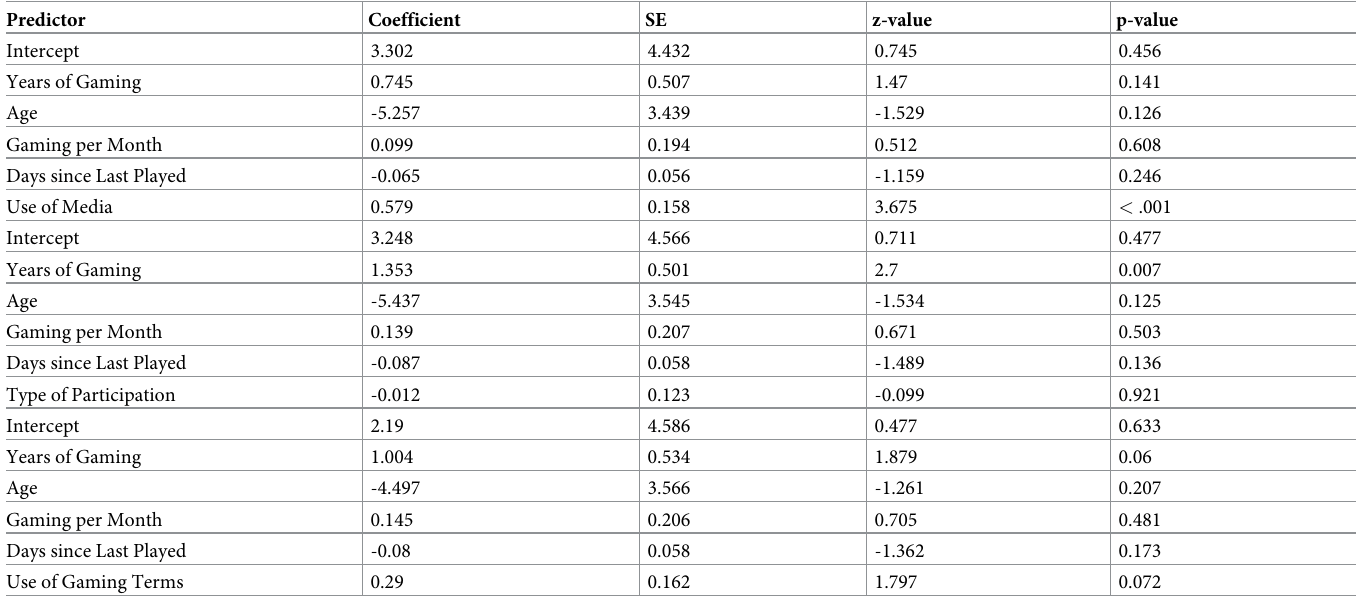
Table 6. Experiment 2: Mixed logit analyses of participant response predicted by gaming experience, use of media, type of participation, and use of gaming terms.